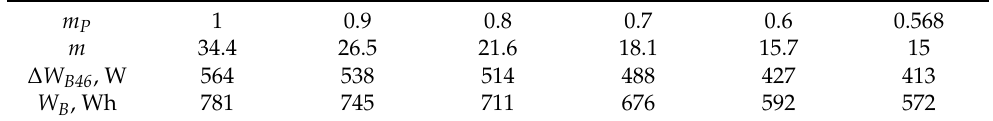
Table 2. Calculated values of system